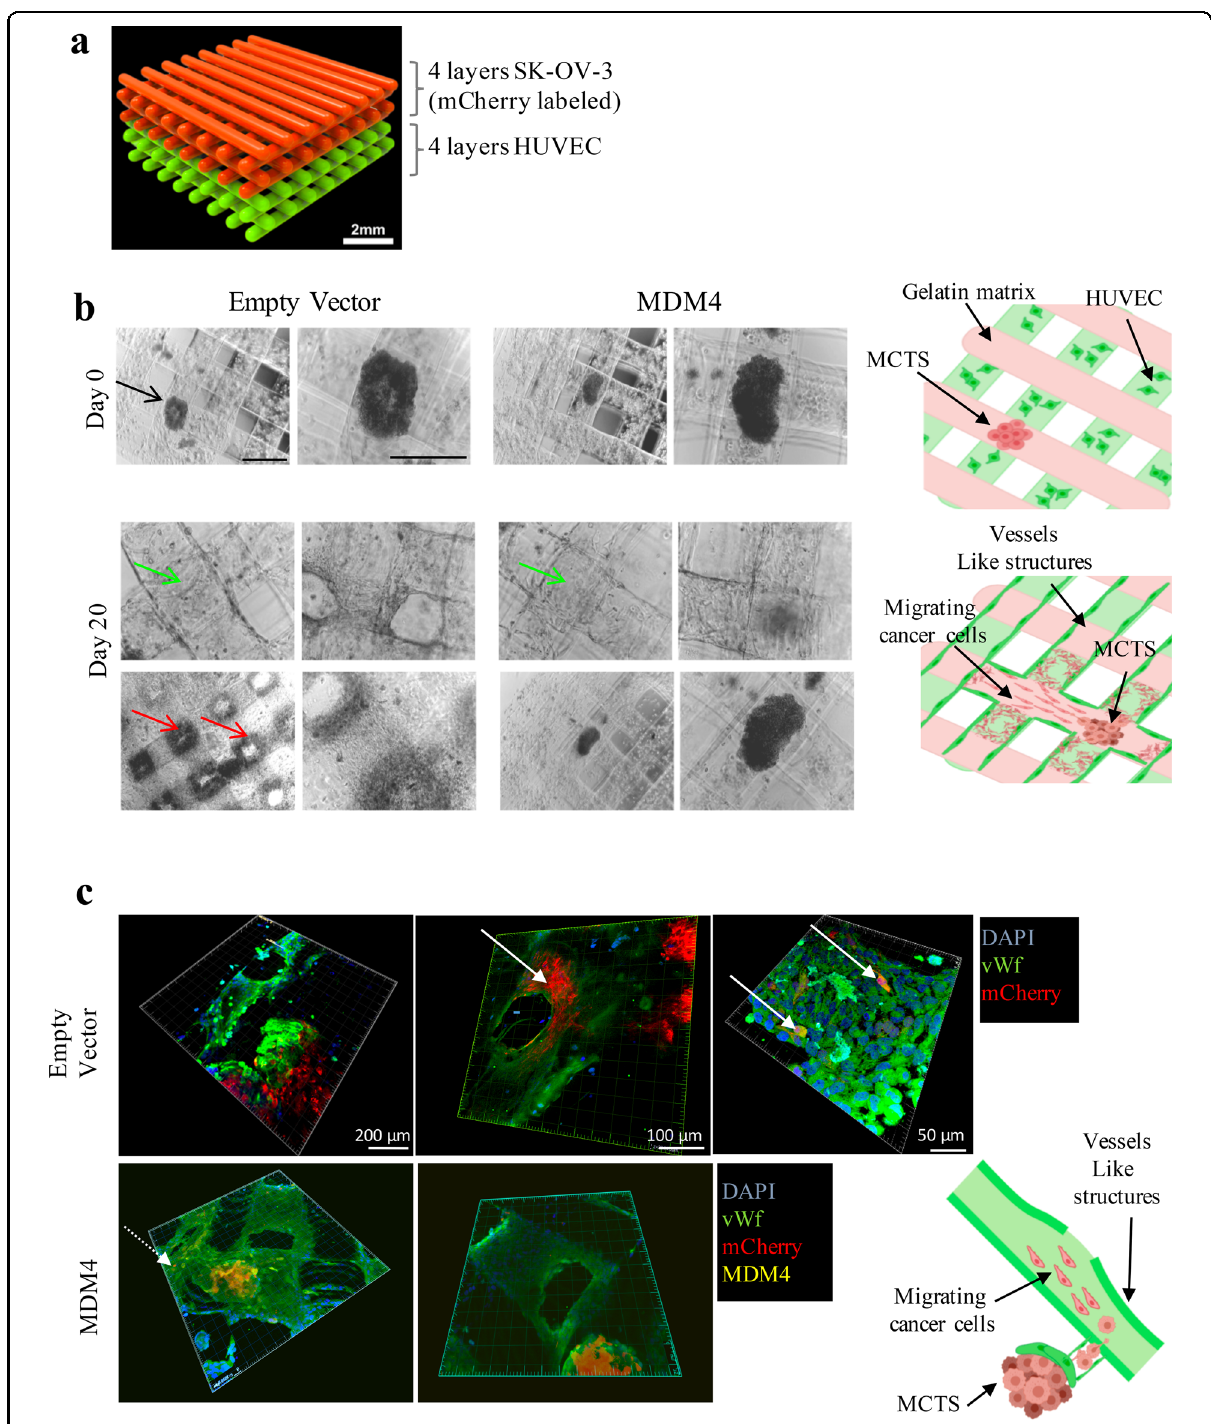
Fig. 3 Cell spreading is impaired by MDM4 in a 3D-bioprinting assay. a Rendering of the 3D-bioprinting geometry used. b Representative pictures of bioprinted constructs carrying MCTS and HUVEC at day 0 (upper panels, black arrow points to the MCTS) and day 20 after bioprinting (lower panels); red and green arrows point to cancer cells spreading and to vessels-like structures, respectively. Right panels show the rendering of day 0 bioprinting strategy (upper panel) and cell invasion at day 20 (lower panel); scale bars = 200 mM. c Confocal microscopy of constructs showing the vessels-like structures (stained with sheep anti-Von Willebrand Factor AbCam Cat# ab11713, green signal), cancer cells expressing mCherry (red signal), and MDM4 (stained with Mouse anti-MDM4 Ab OriGene Cat# TA505706, yellow signal), DAPI stains nuclei. White arrows point to migrating cancer cells. The drawing shows the rendering of cancer cells escaping from the MCTS and entering vessels-like structures.